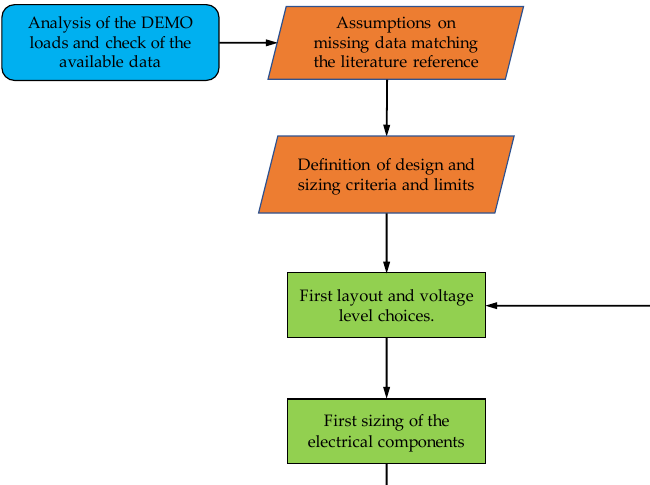
Table 3. Electrical data of the MV/MV and MV/LV transformers.